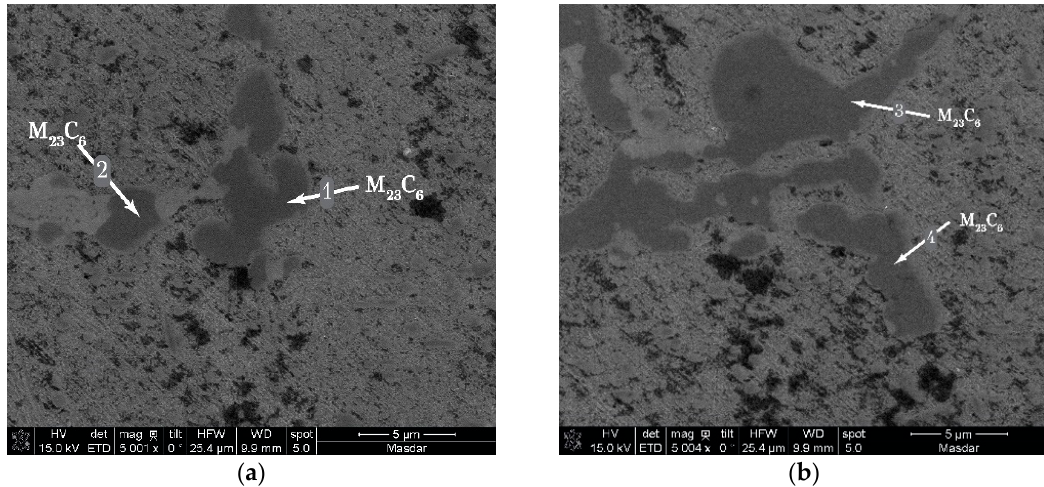
Figure 5. SEM images, ( a , b ), depicting M 7 C 3 carbides and G-phase in condition M. Numbers indicate EDX composition analysis in Table 2.